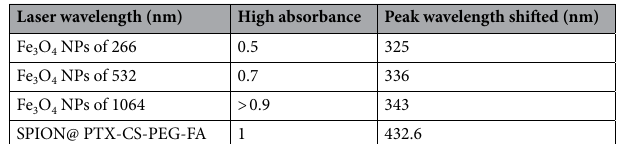
Laser wavelength (nm) High absorbance Peak wavelength shifted